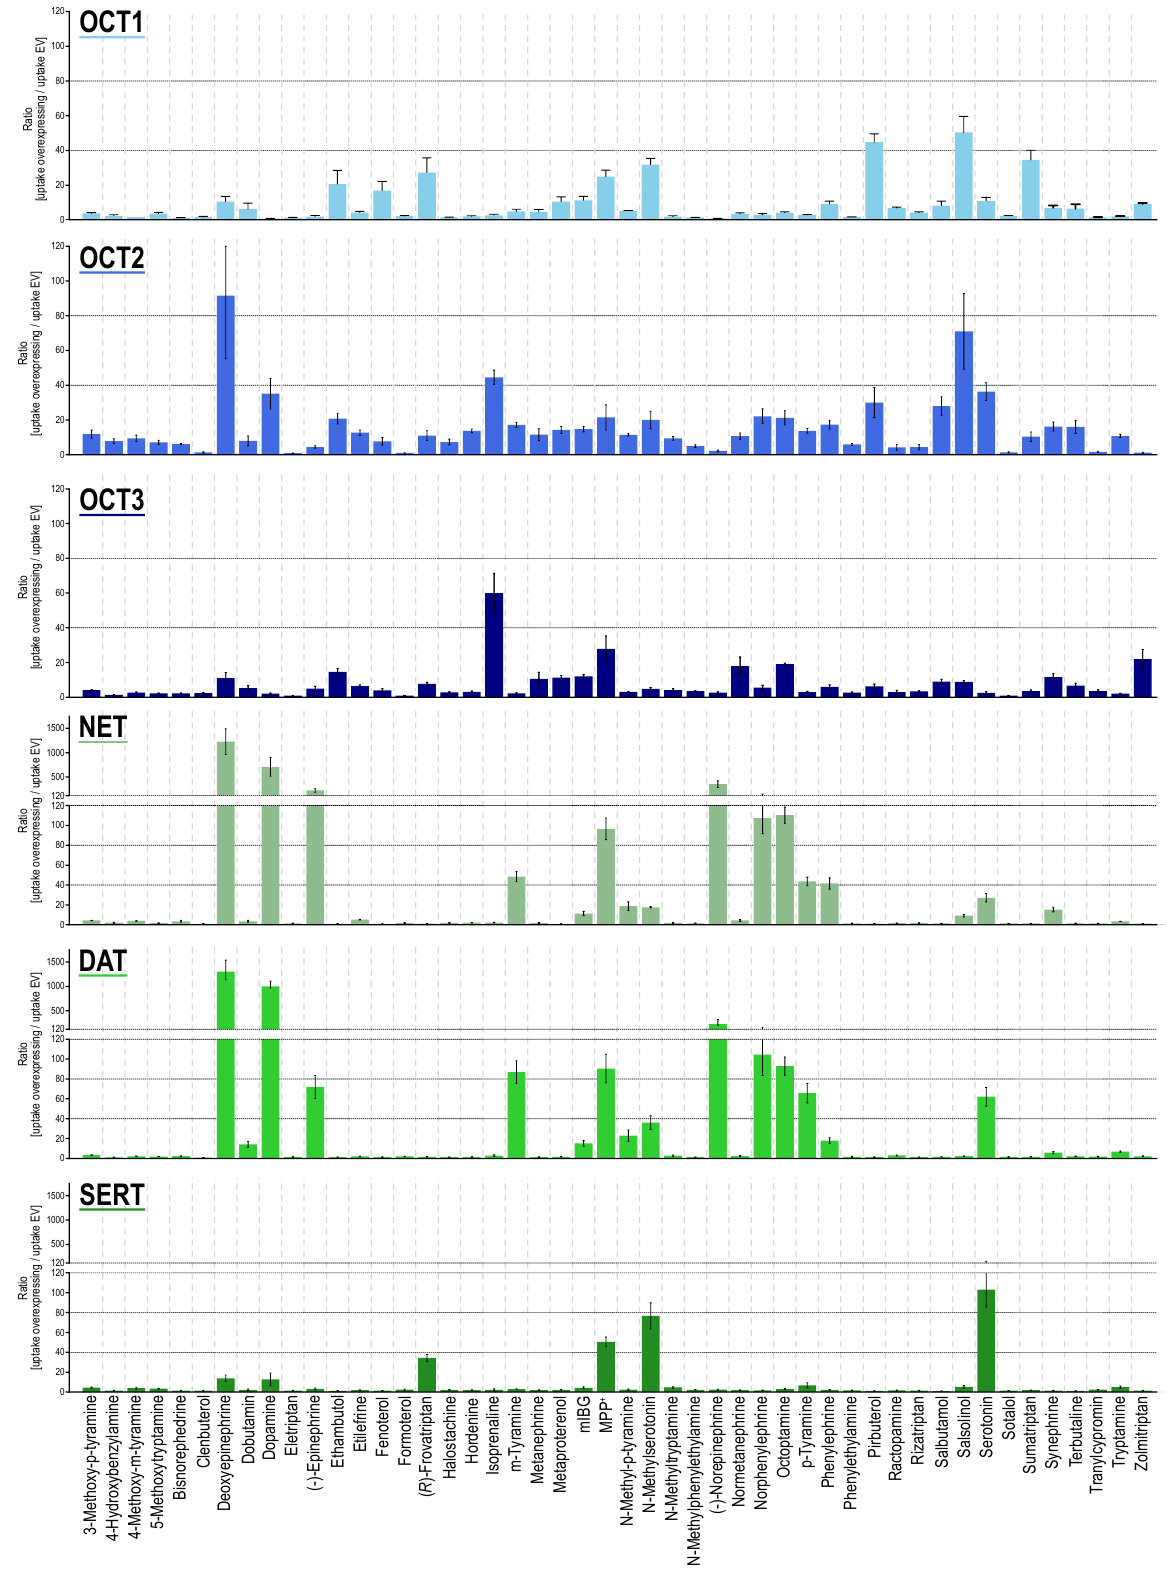
Figure 1. Transport ratios, uptake into overexpressing cells over uptake into empty-vector control cells for compounds as shown on the x-axis (alphabetical order). HEK293 cells were incubated with 2.5 µ M of each respective compound for two minutes (five minutes for epinephrine and norepinephrine). Data are provided as the means with error bars indicating the SEM of at least three independent experiments. Uptake ratios were tested for statistical significance using one sample t -tests with an α -value of 0.05 as reported in Table